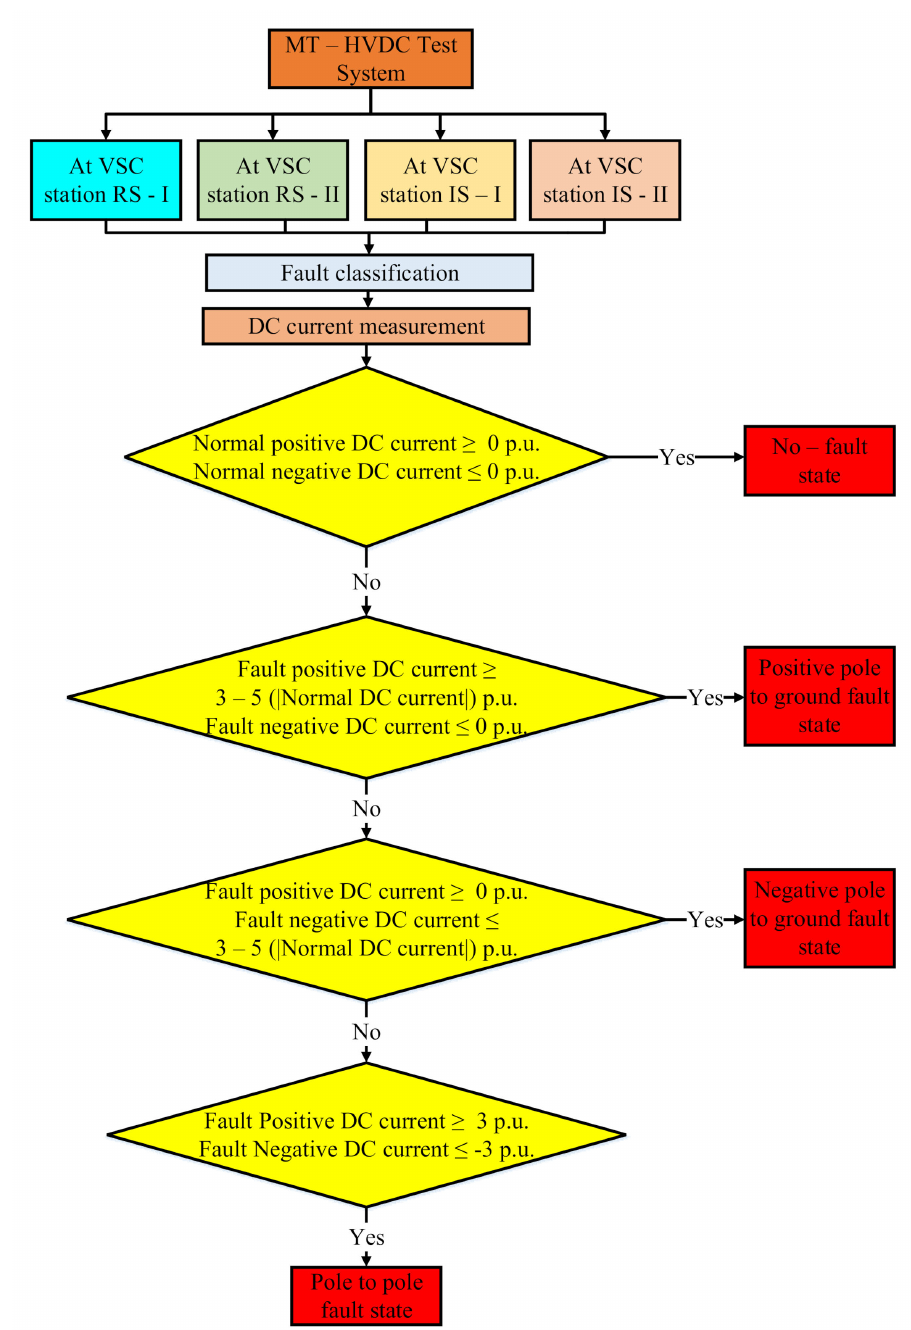
Figure 28. Fault classification scheme based on DC current in the MT-HVDC test